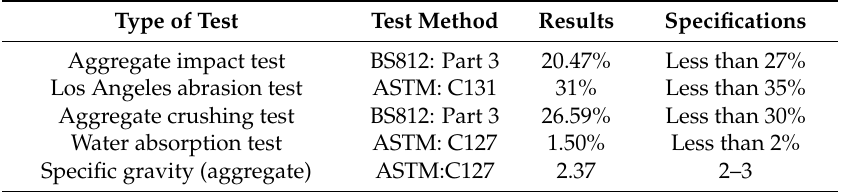
Table 2. Standards of testing aggregate